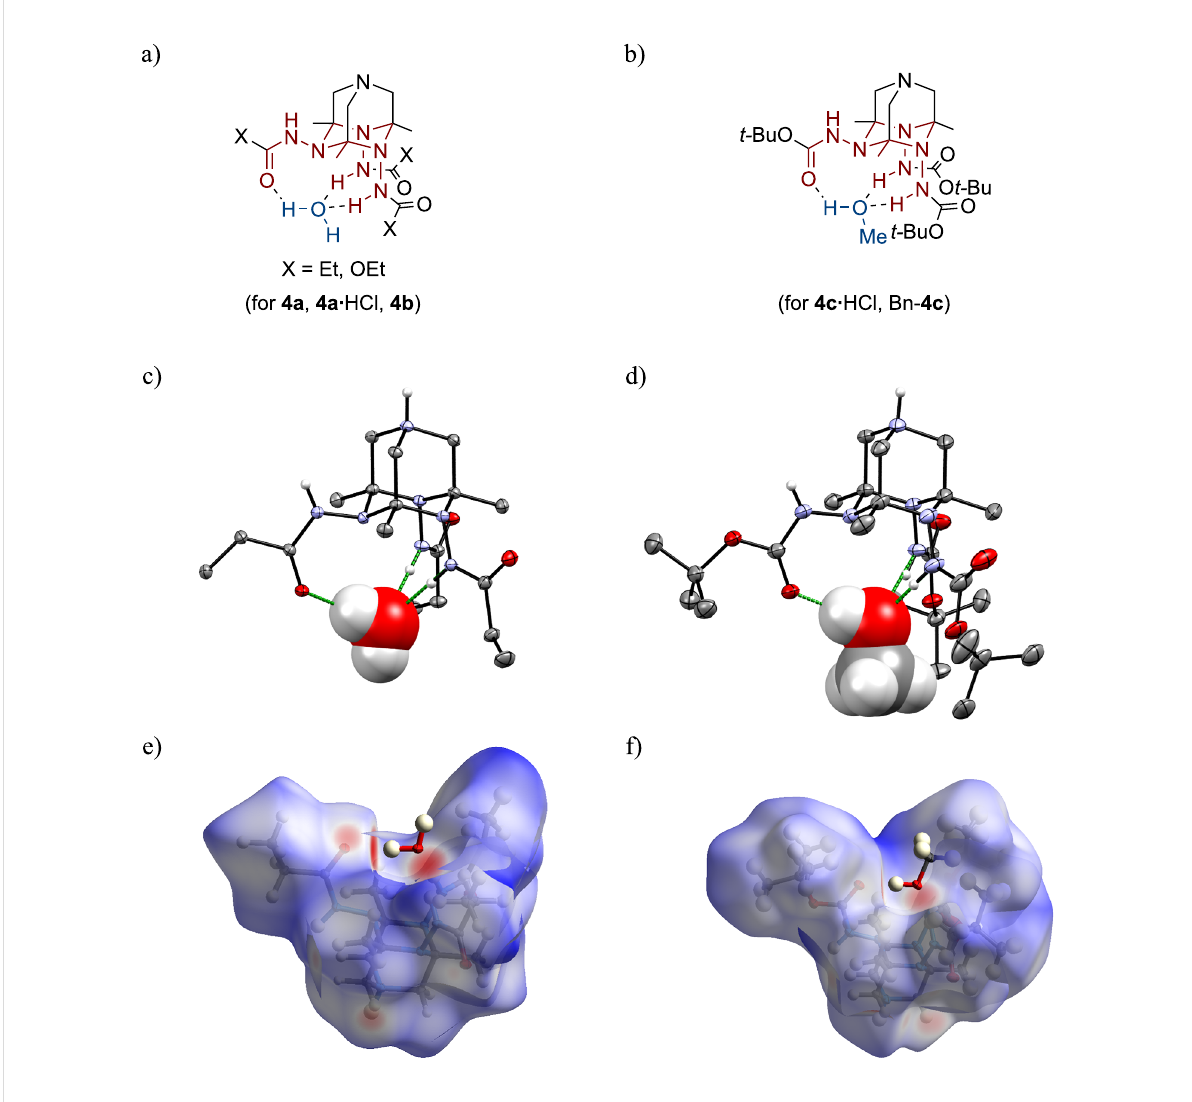
Figure 3: (a) General structure of host–guest complexes of 3 N -TAADs with water. (b) The general structure of host–guest complexes of 3 N -TAADs with methanol. (c) Host–guest motif in the X-ray structure of 4a ·HCl·H 2 O·MeOH (guest molecule is shown in “spacefill” representation). (d) Host–guest motif in the X-ray structure of 4c ·HCl·3.5MeOH (guest molecule is shown in “spacefill” representation). (e) Hirshfeld surface of the TAAD cation in 4a